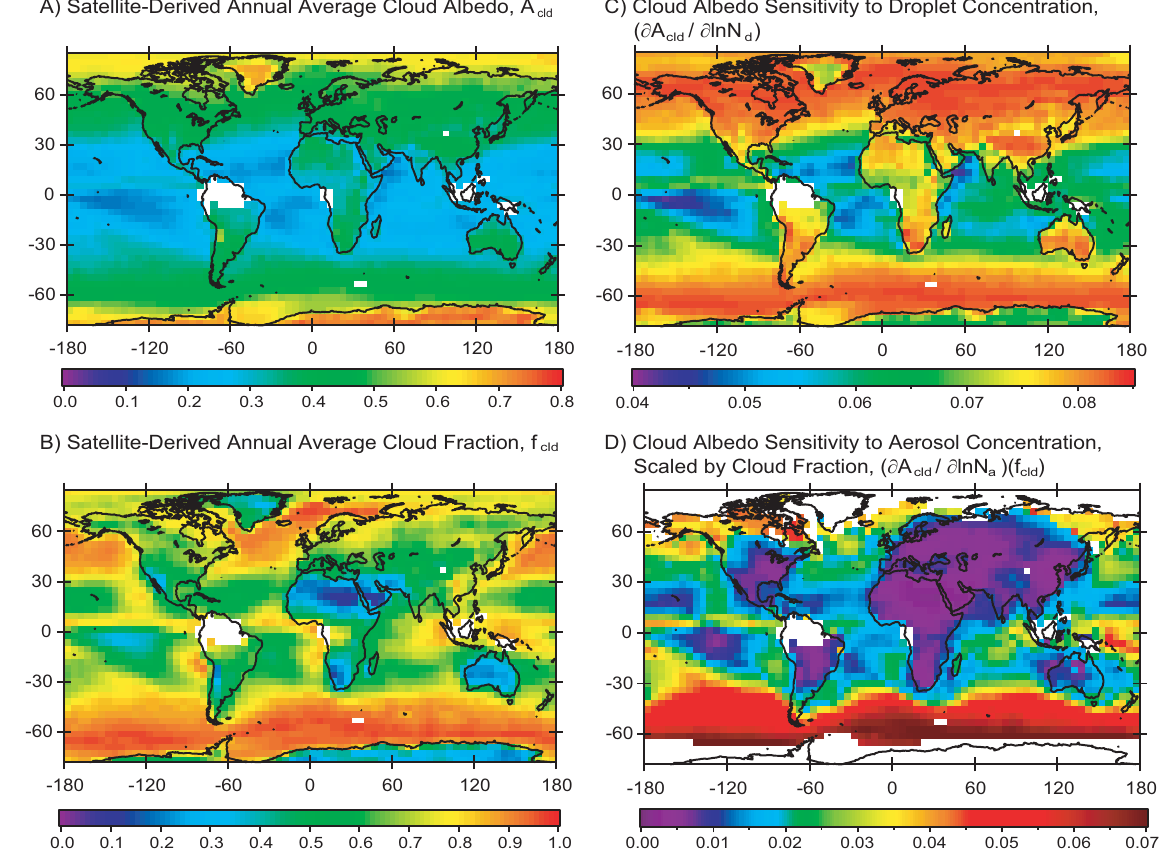
Fig. 3. Global spatial distribution of the annual mean A cld computed from Eq. (1) using NASA CERES satellite data (A) , the annual mean MODIS satellite-derived cloud fraction (B) , the derived semi-logarithmic sensitivity of A cld to N d (C) , and the derived semi-logarithmic sensitivity of A cld to N a scaled by cloud fraction (D)